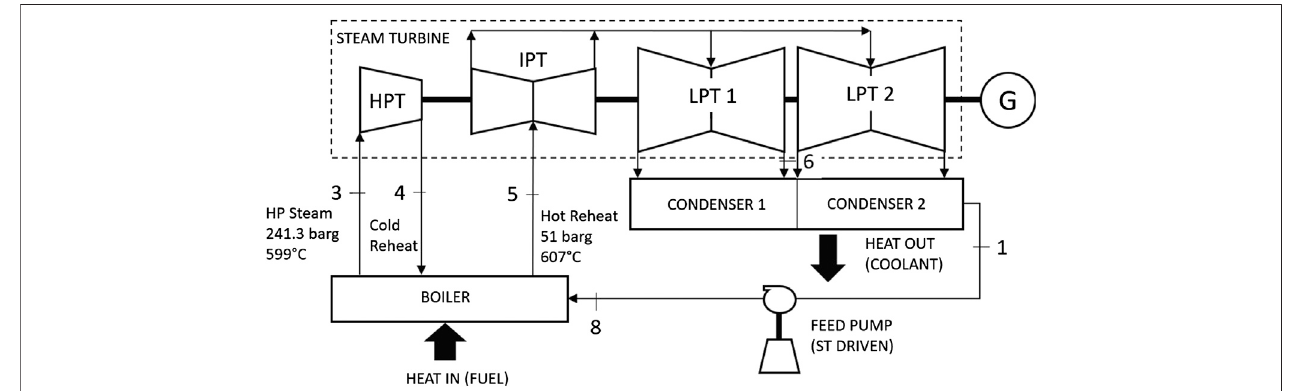
FIGURE 5 | Simpli fi ed steam turbine cycle